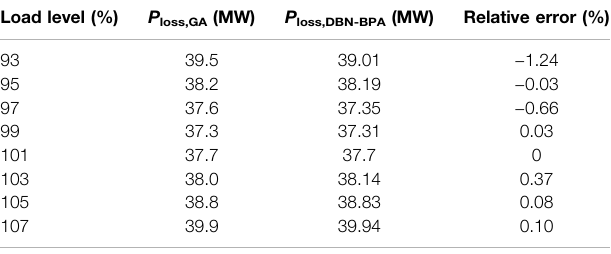
TABLE 6 | Errors of the optimization results based on deep belief network (DBN) and BPA. Load level